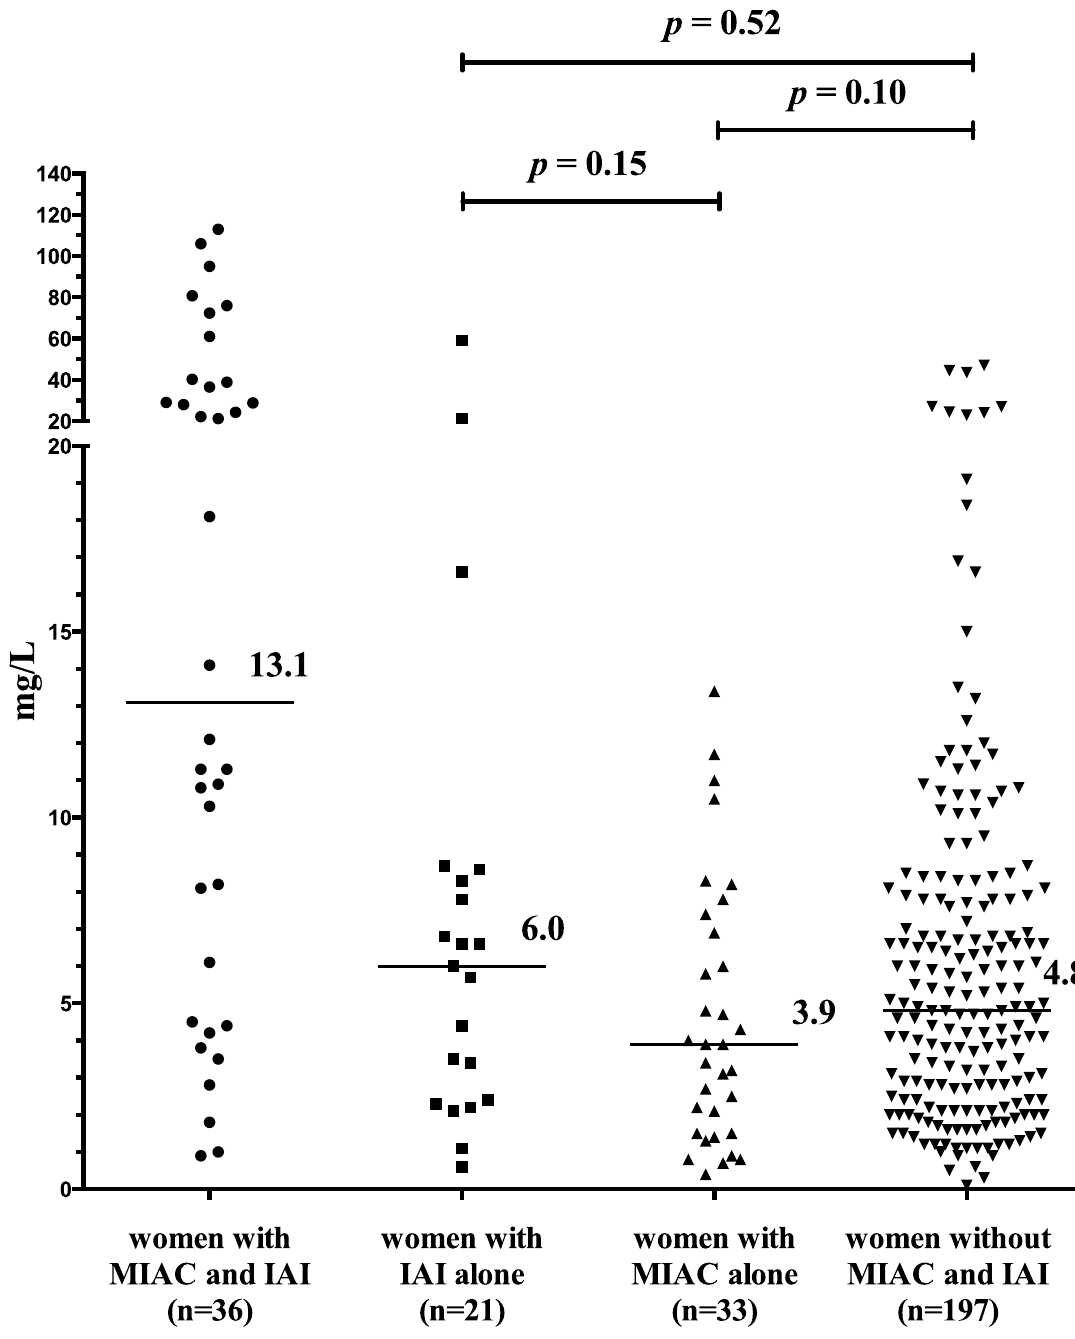
Fig 3. Maternal serum C-reactiveprotein concentrations in PPROM pregnancies complicated by the presenceof MIAC and/or IAI. No differences were found amongwomen with IAI alone, MIAC alone, and women without MIAC and IAI. Abbreviations: MIAC, microbialinvasionof the amniotic cavity; IAI, intra-amniotic inflammation.